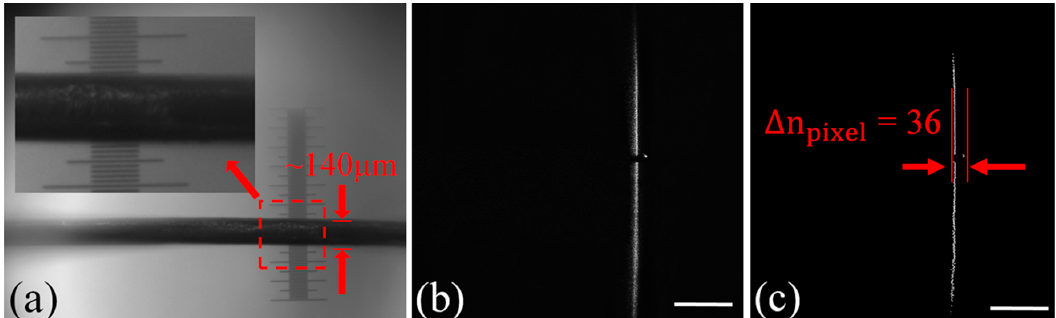
Figure 6. Measurement of the diameter of a single strand of hair at one position. ( a ) Strand of hair placed on micrometer ruler with a resolution of 10 μ m. ( b ) Measured contoured image of the strand of hair. ( c ) Enlarged view of ( b ) to indicate pixel offset Δ n pixel = 36 due to the light-sheet modulation. Scale bar: 1 mm.